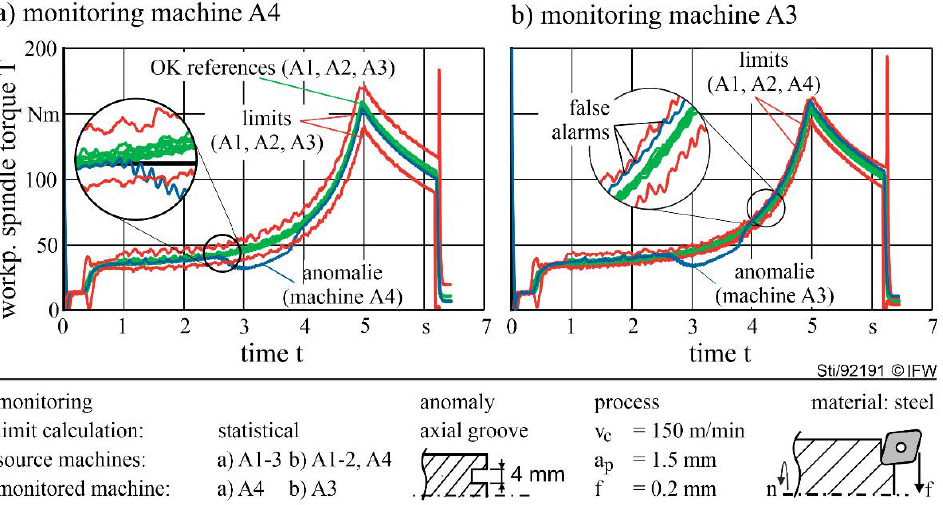
Figure 8. Transfer of monitoring limits among machines of the same model and without process component isolation. ( a ) Anomaly detected and no false alarms with machine A4 as a target. ( b ) Anomaly detected, but several false alarms with machine A3 as a monitoring target.